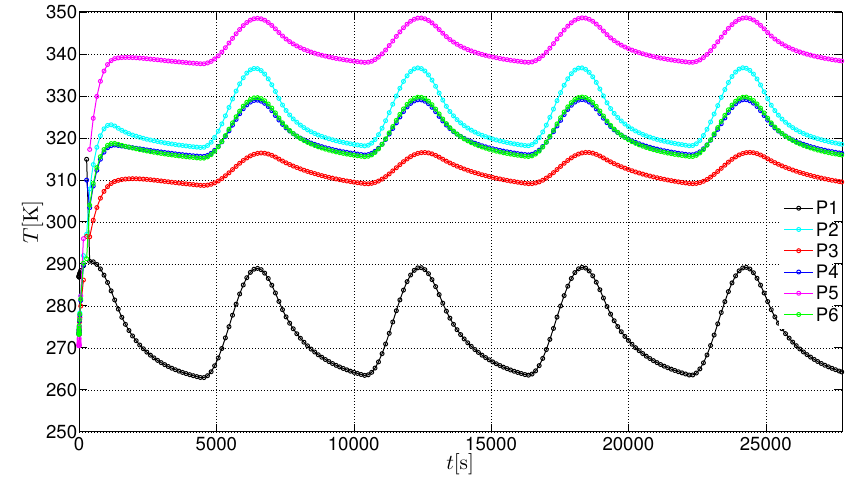
Figure 10. Average temperature in each composite panel as function of time ( β = 90 ◦ ).